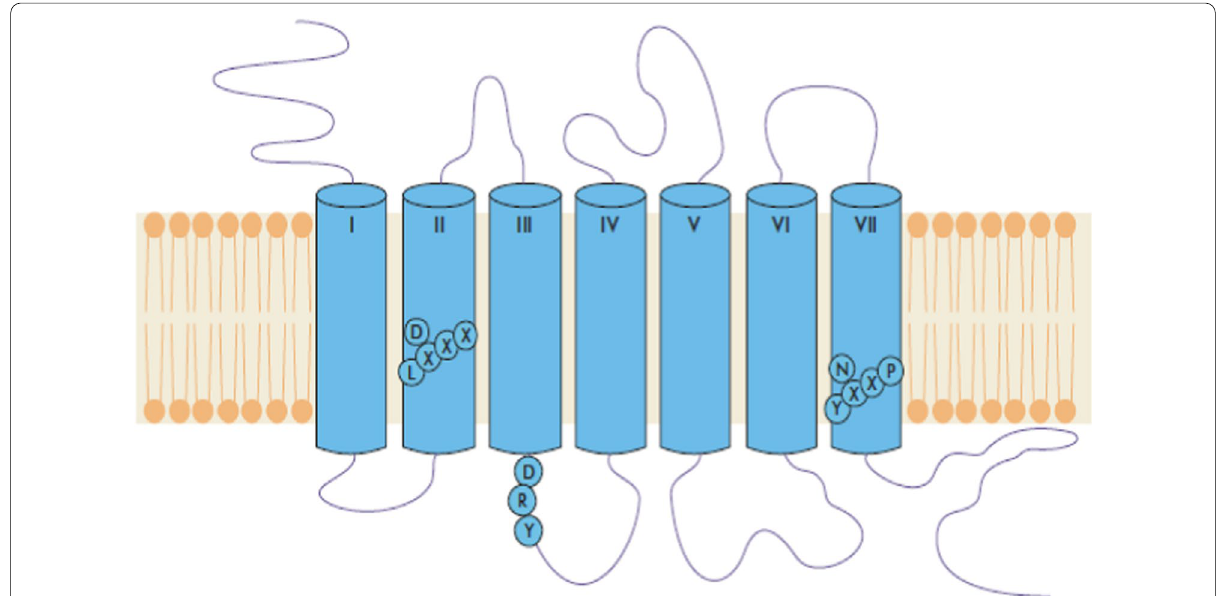
Fig. 1 Schematic Representation of GPCRs showing the 7 Helices, the connecting loops and some conserved amino acid